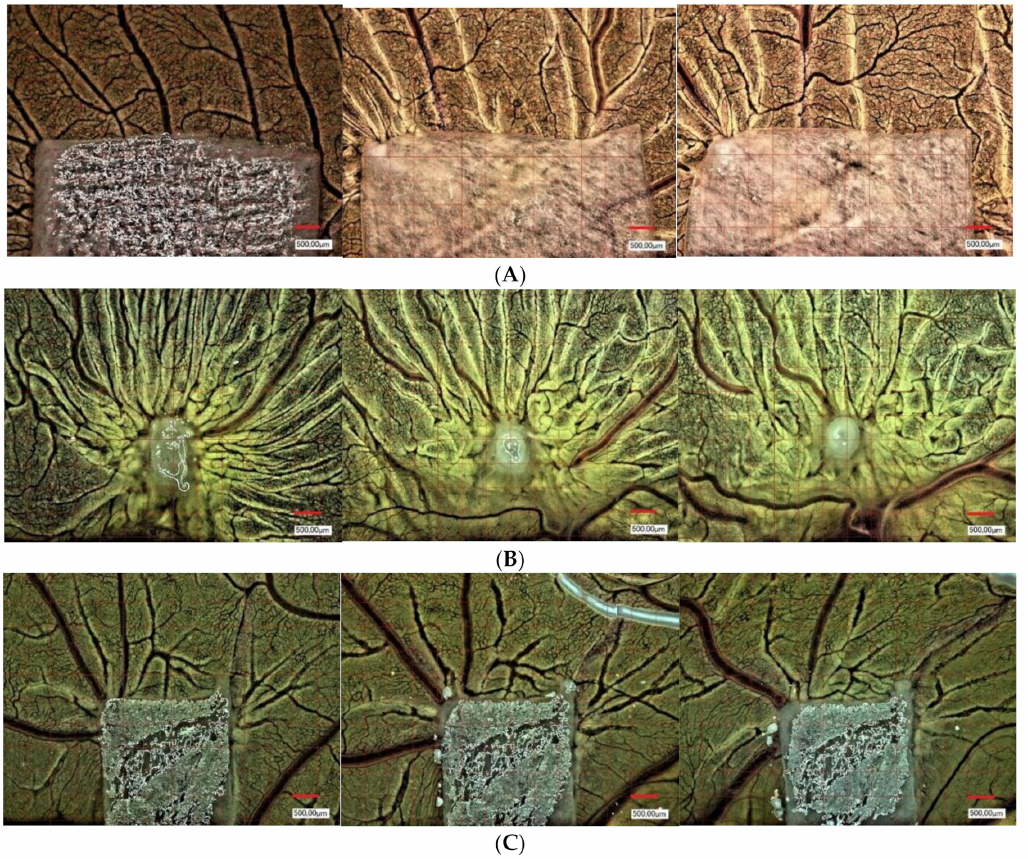
Figure 1. Example of microscopic analysis. ( A ) Bio-Gide ® matrix, ( B ) PRF matrix, ( C ) Symbios ® matrix after 24, 48 and 72 h in the YSM assay. Magnification: